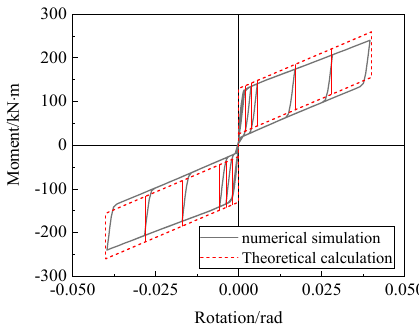
Figure 13. Comparison of joint restoring force.